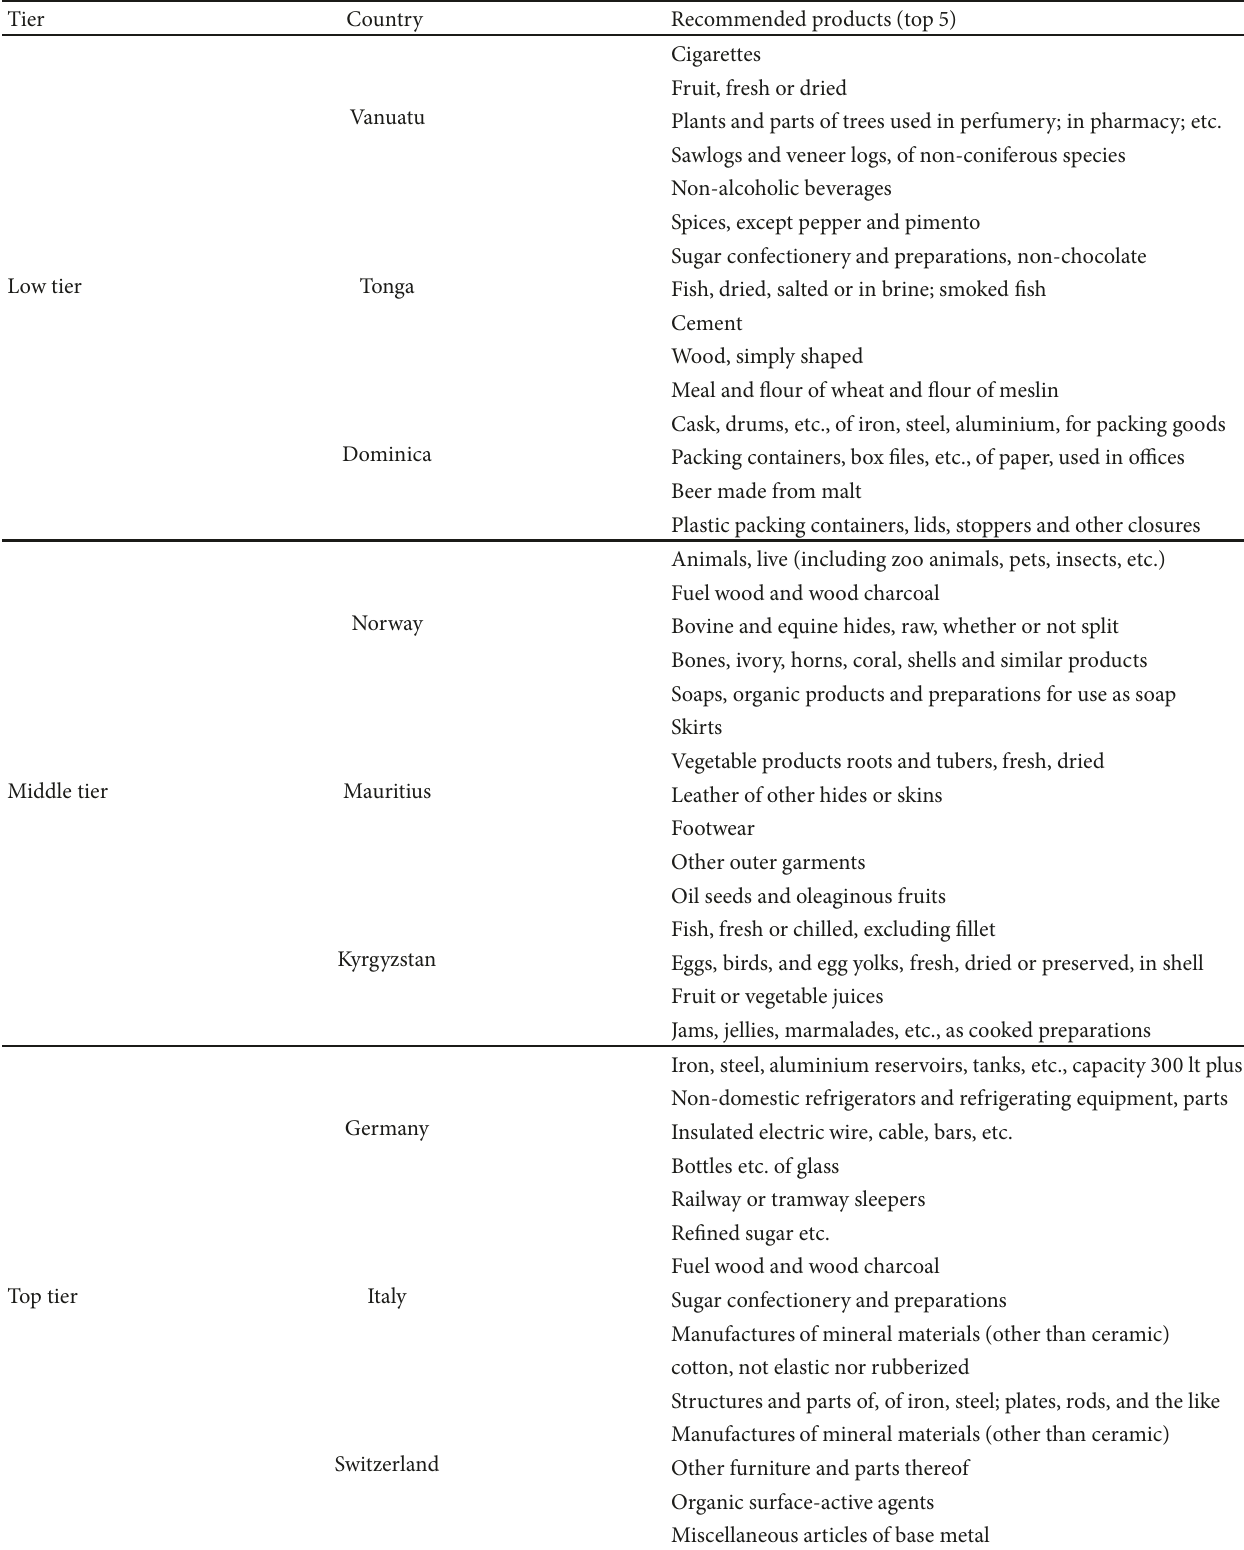
Table 1: The top five recommended products by TProbS algorithms for three randomly selected countries in different